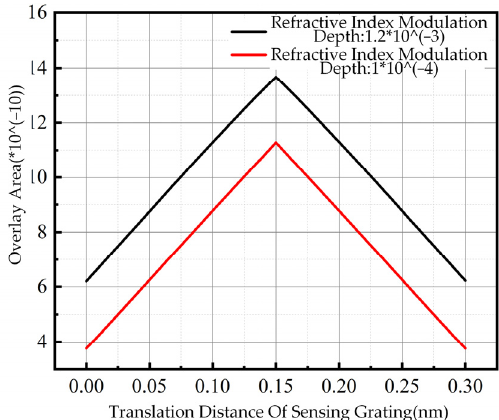
Figure 6. Variation curves of spectral superimposed area as a function of the translation distance of sensing grating when L = 10 mm, and the refractive index modulation depth is 1.2 × 10 − 3 and 1 × 10 − 4 .